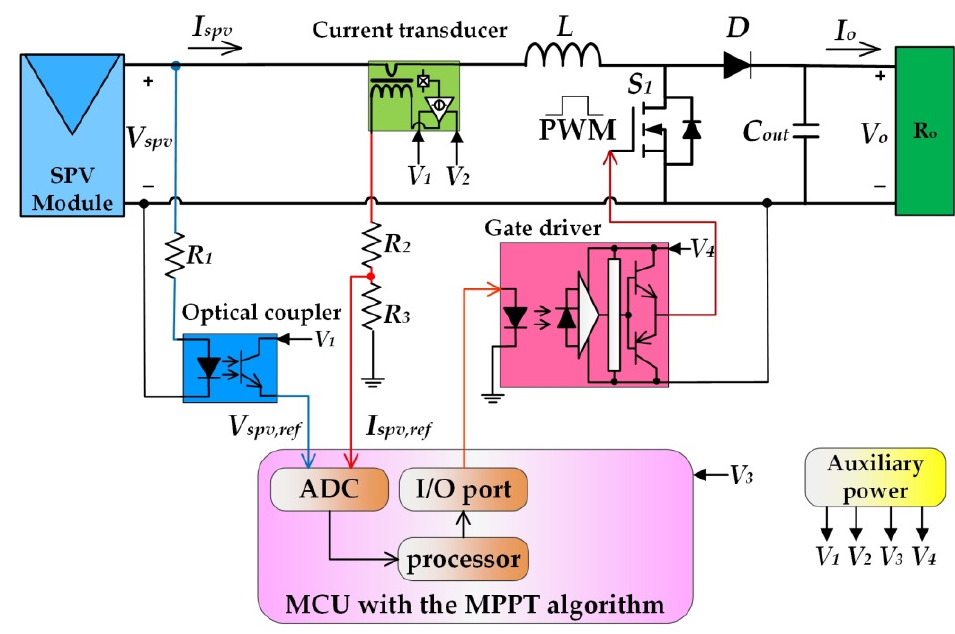
Figure 6. The boost converter with the MPPT algorithm ‐ embedded diagram.